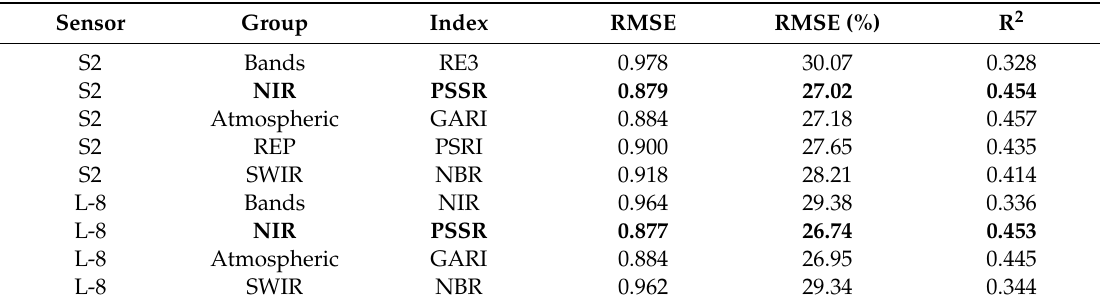
Table 1 : Model fit and RMSE of the best spectral bands and vegetation indices by index group for Sentinel-2 (S2) and Landsat-8 (L-8) at 60-m pixel window size. Best-performing indices are highlighted in bold.